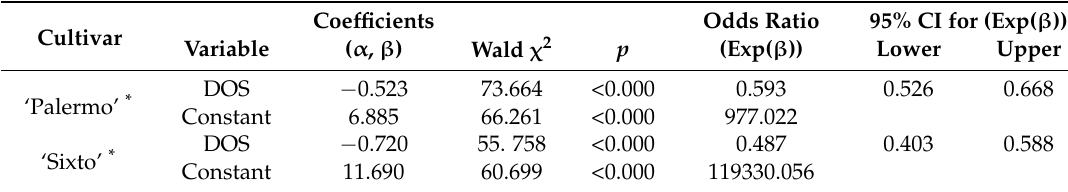
Table 3. Estimation of independent simple logistic regression parameters for each red pepper cultivar, ‘Palermo’ and ‘Sixto’, as a function of the number of days of storage (DOS), a factor influencing the probability of